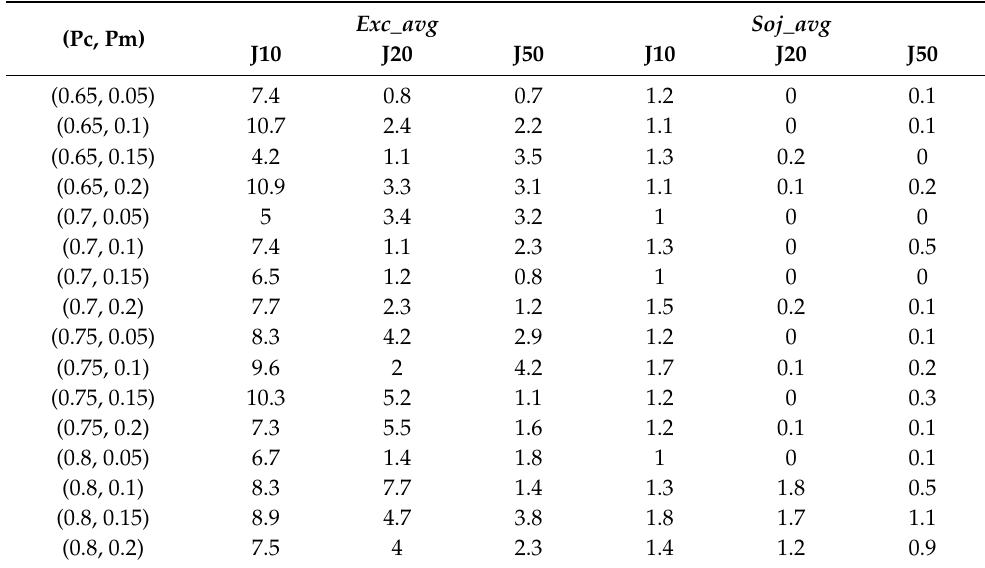
Table 3. Test results with different parameter